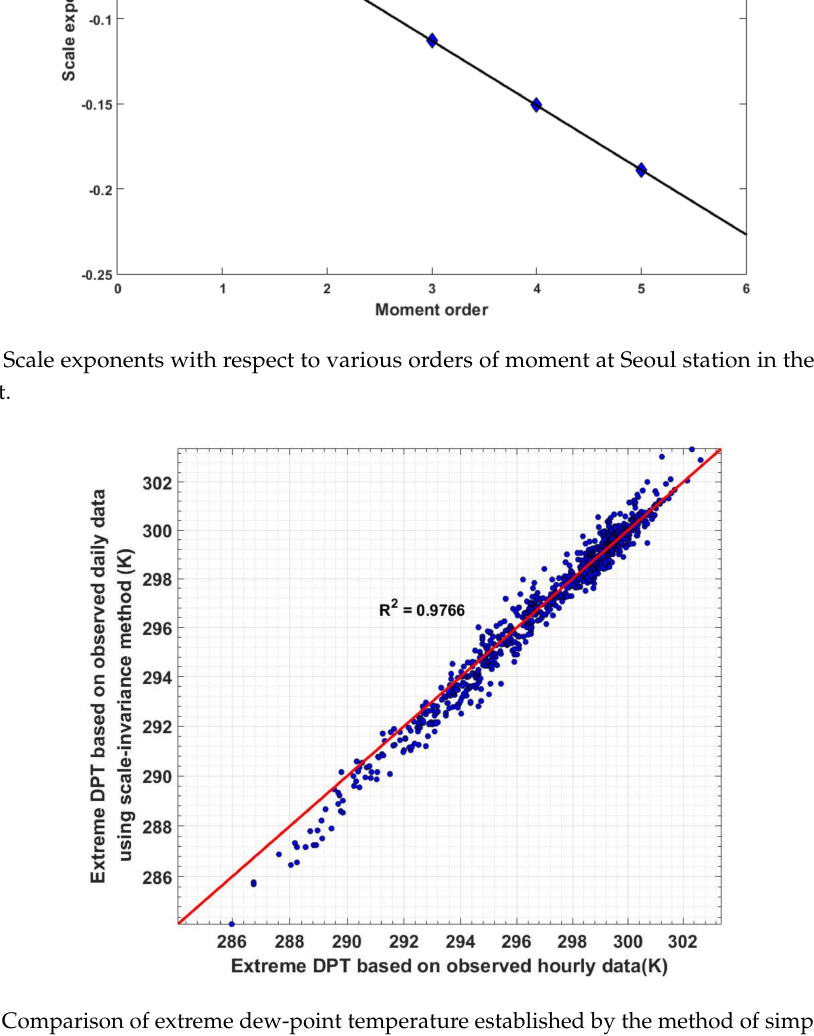
Figure 6. Comparison of extreme dew-point temperature established by the method of simple scaling and sample quantiles’ estimates for return period of 100-year and persistence interval of 12-h at Seoul station in the first half of